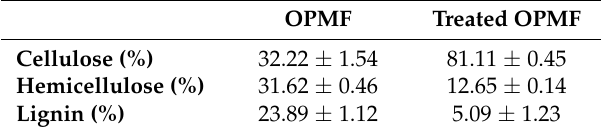
Table 1. Chemical composition of oil palm mesocarp fiber (OPMF) and treated OPMF. OPMF